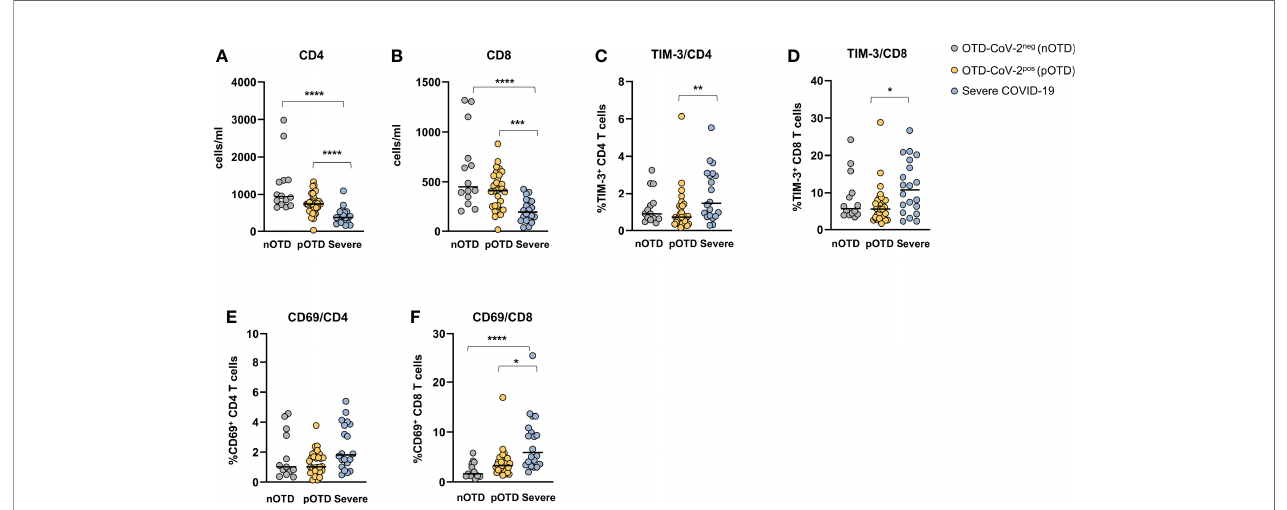
FIGURE 6 | Hyperactivated/exhausted T cell phenotype in patients with severe COVID-19. Absolute numbers of circulating (A) CD4 + and (B) CD8 + T cells. (C, D) . Expression of the TIM-3 checkpoint molecule and (E, F) of the CD69 activation marker on CD4 + and CD8 + T cells. Statistical comparison between three groups of subjects was assessed by the non-parametric Kruskal-Wallis test followed by Dunn ’ s multiple comparisons. *p < 0.05; **p < 0.01; ***p < 0.001; ****p <